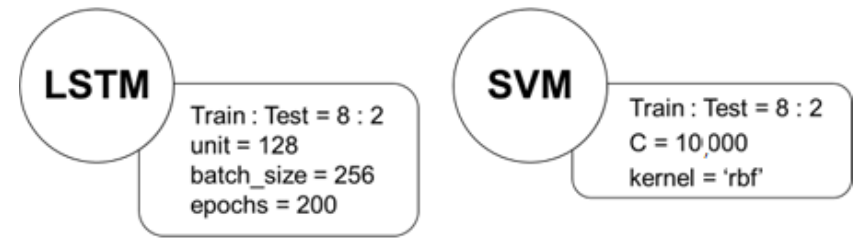
Figure 6. Both model parameters (where ‘rbf’ is the radial basis function).